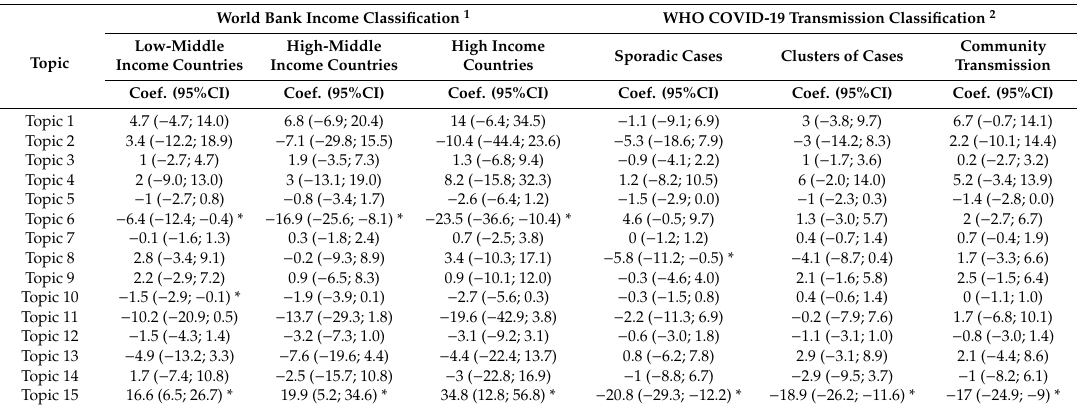
Table 3. Regression models to identify the research trend among countries with di ff erent income level and epidemic